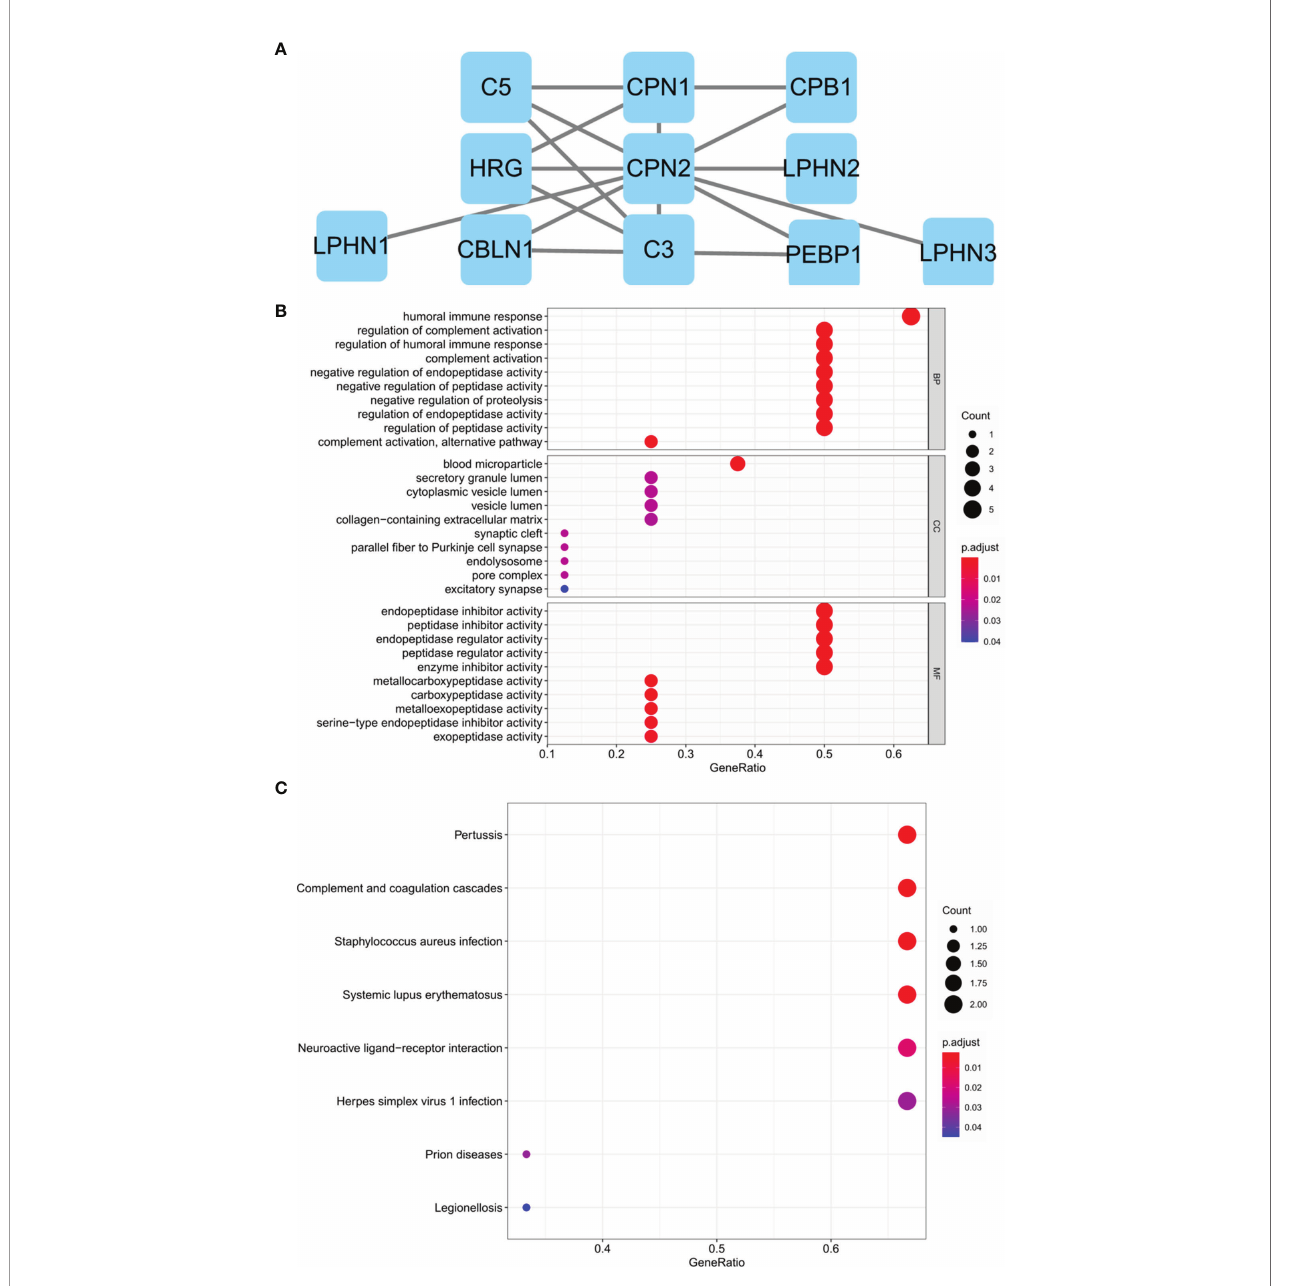
FIGURE 6 | Protein – protein interaction network and functional enrichment analysis of genes interacted with CPN2 through Search Tool for the Retrieval of Interacting Genes/Proteins (STRING) analysis. (A) Ten genes interacted with CPN2 con fi rmed by STRING database. (B) Gene ontology biological process enrichment analyzed by these interaction genes. (C) Kyoto Encyclopedia of Genes and Genomes enrichment analyzed by these interaction genes. False discovery rate <0.5 was considered statistically signi fi